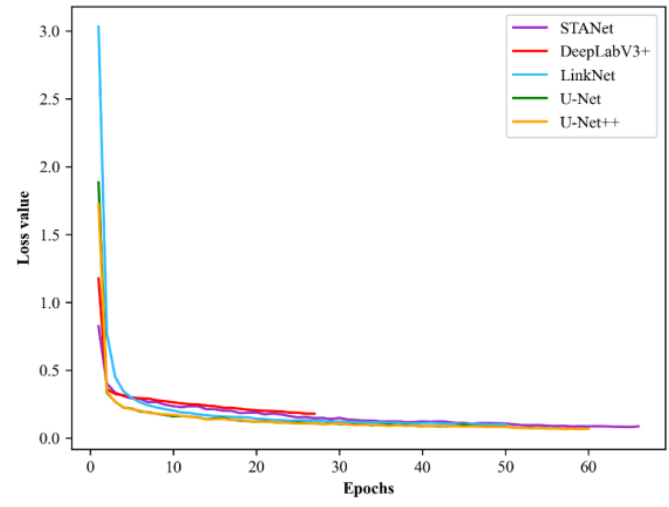
Figure 8. Loss curve for each model.